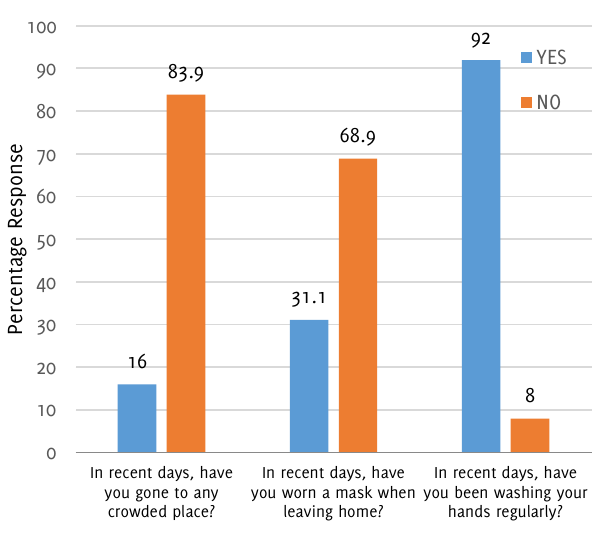
Figure 3 . Percentage Responses to Questions on Preventive Strategies Against COVID-19.